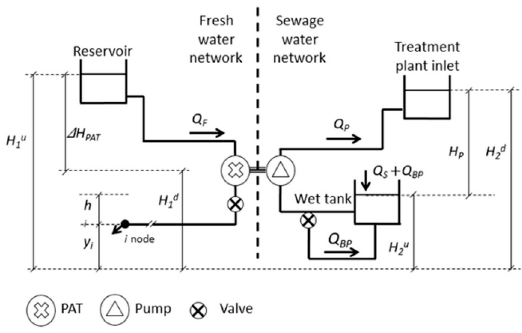
Figure 14. Hydraulic scheme of a freshwater turbine–wastewater pump system [22]. Water 2020 , 12 , x FOR PEER REVIEW